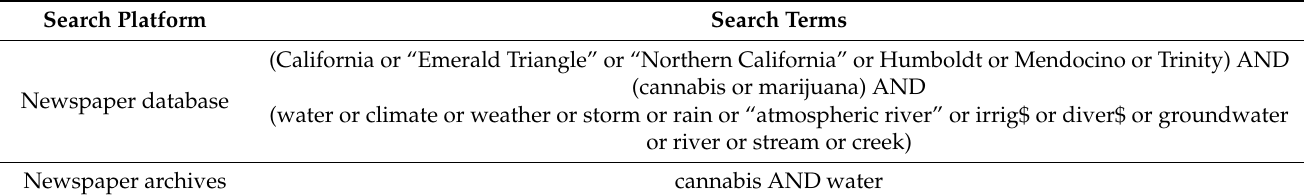
Table 1. Search terms used for each search platform (newspaper database and newspaper archives specific to a given local